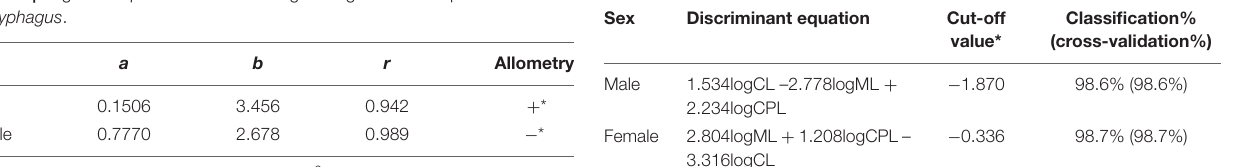
a = constant, b = regression coefficient, R 2 = coefficient of determination, r = correlation coefficient, + = positive allometry, − = negative allometry, * = p < 0.001 (t-test of b value, b = 3).